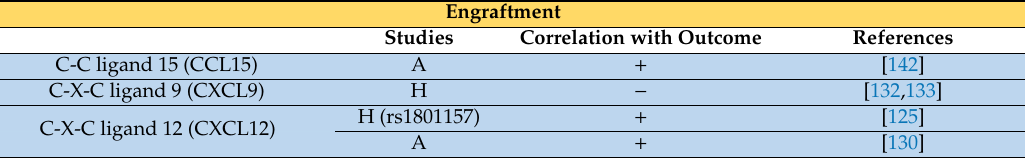
Table 2. Engraftment in animal (A) or human (H) studies. In humans, engraftment is measured by either the time to platelet / neutrophil recovery, chimerism, or the absence of graft failure. In animals, genetic manipulation allows for various measures of engraftment. See the Methods section regarding the reporting of results (Section